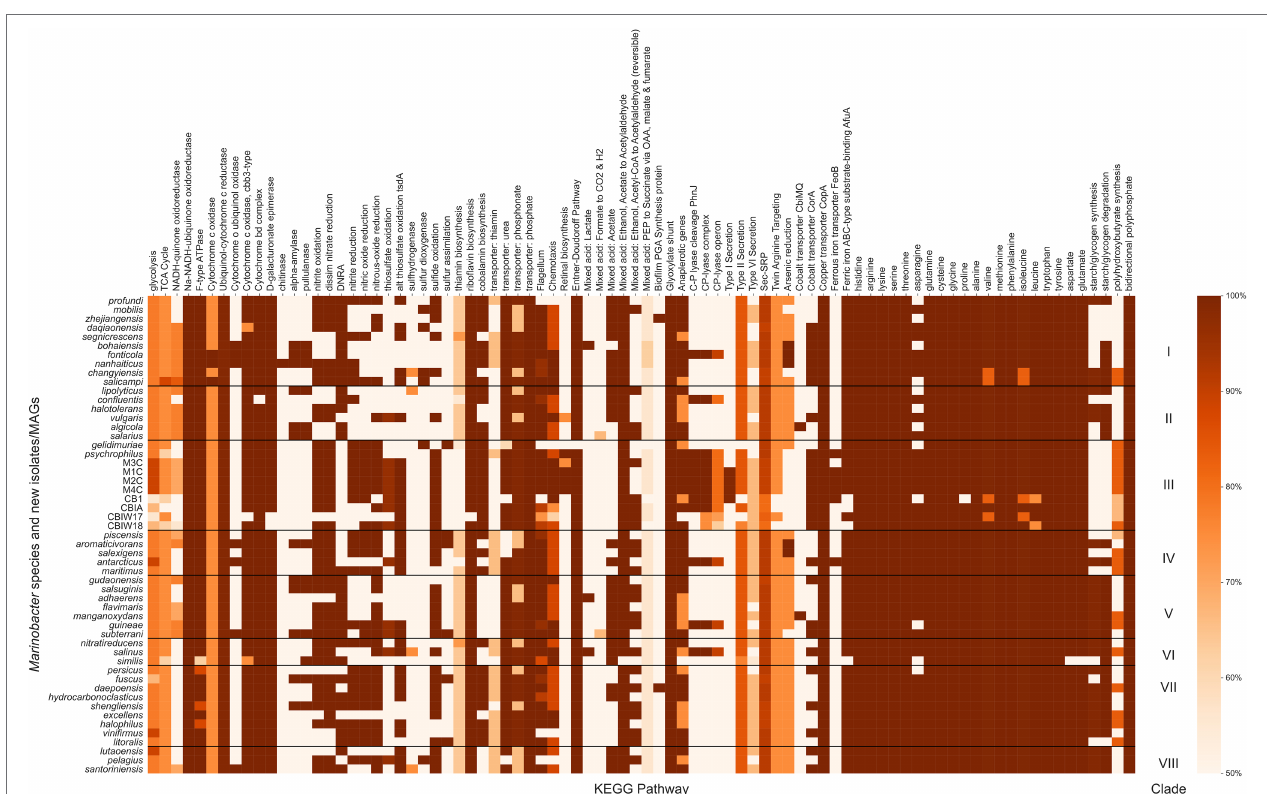
FIGURE 4 | Heatmap of the completeness level of Kyoto Encyclopedia of Genes and Genomes (KEGG) metabolic pathways identified by KEGG Decoder for Marinobacter genomes. All pathways plotted were at least 50% complete in at least one genome. The colormap ranges from 50% (lightest orange) to 100% (darkest orange). Each row represents a single Marinobacter genome, and each column represents a metabolic pathway. Black horizontal lines separate the heatmap into clades with clade numbers listed between the heatmap and the scale